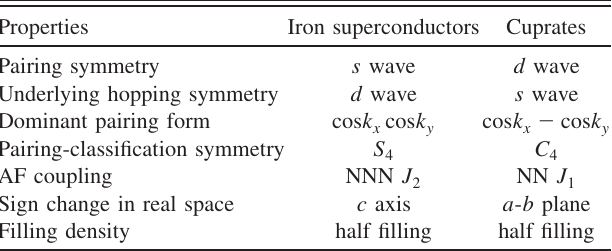
TABLE I. A list of the close connections between iron-based superconductors (iron SCs) and